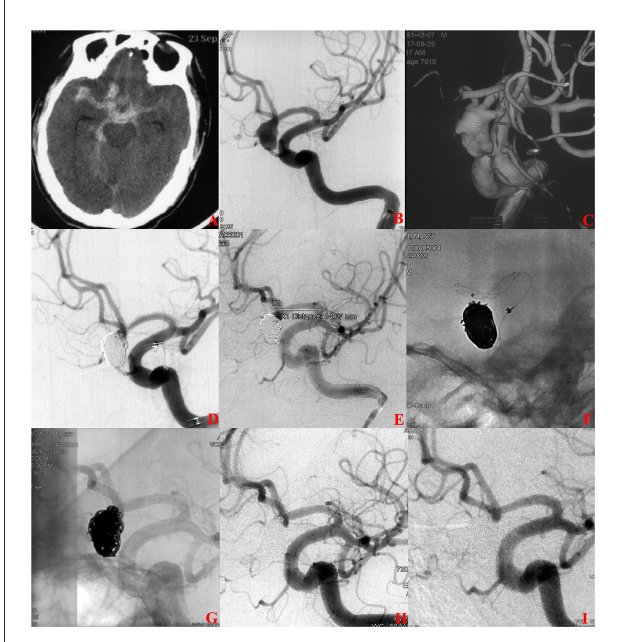
FIGURE2 A ruptured anterior communicating aneurysms (AcomA) intracranial aneurysm treated with staged stent-assisted coiling. (A) The patient was admitted with spontaneous subarachnoid hemorrhage. (B, C) Cerebral angiography and 3D reconstruction revealed a AcomA aneurysm. (D) The aneurysm was treated with coiling embolization only at the initial stage. Immediate angiography showed the residual neck of the aneurysm. (E–G) 28 days later, the 3.5-mm * 15-mm LVIS stent adjunctive coils were deployed as scheduled. (H) Immediate angiography showed that the aneurysm was completely occluded. (I) Eleven months later, angiographic images showed complete occlusion of the